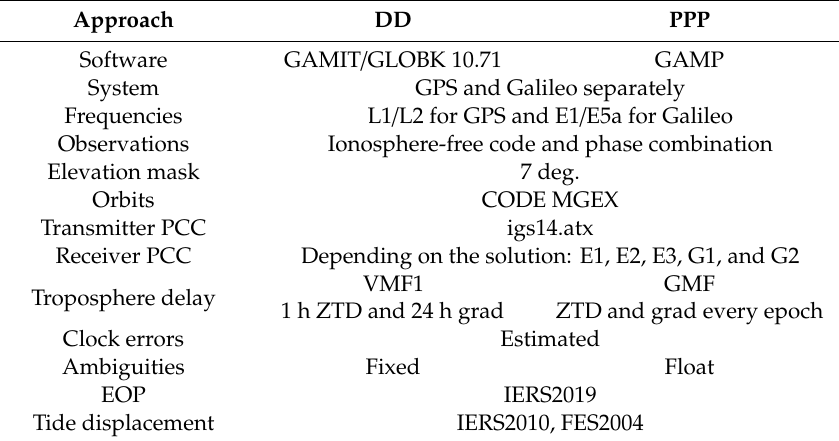
Table 3. Processing parameters adopted for both